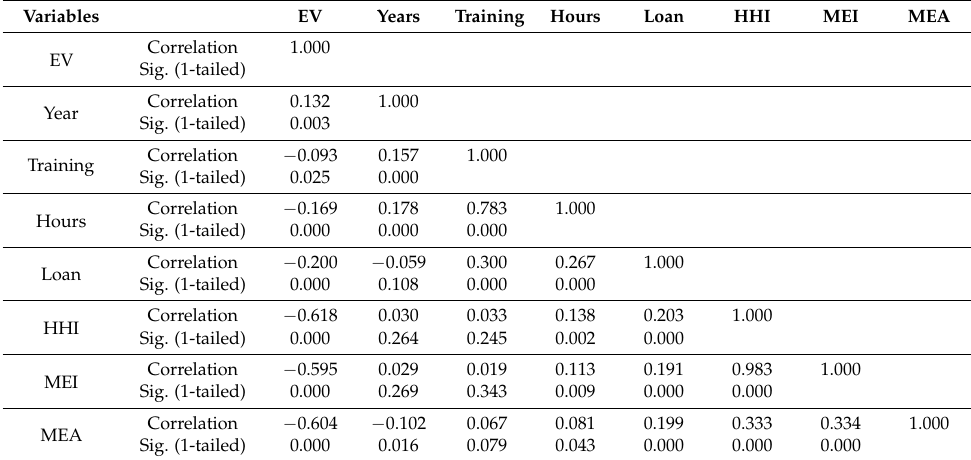
Table 4. The partial